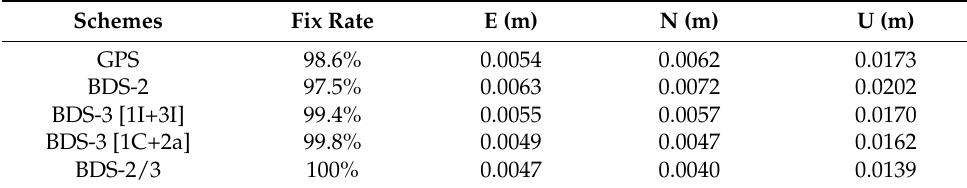
Figure 10. The coordinate error of NRTK fixed solution from different schemes for Station SC17. Table 6. The fixed rate of baseline and positioning RMS of fixed solution from different schemes for Station